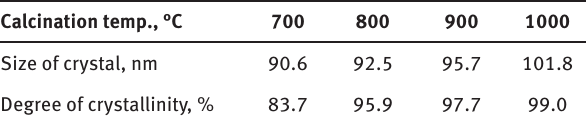
Table 5: Effect of calcine temperature on crystal size and crystal degree of